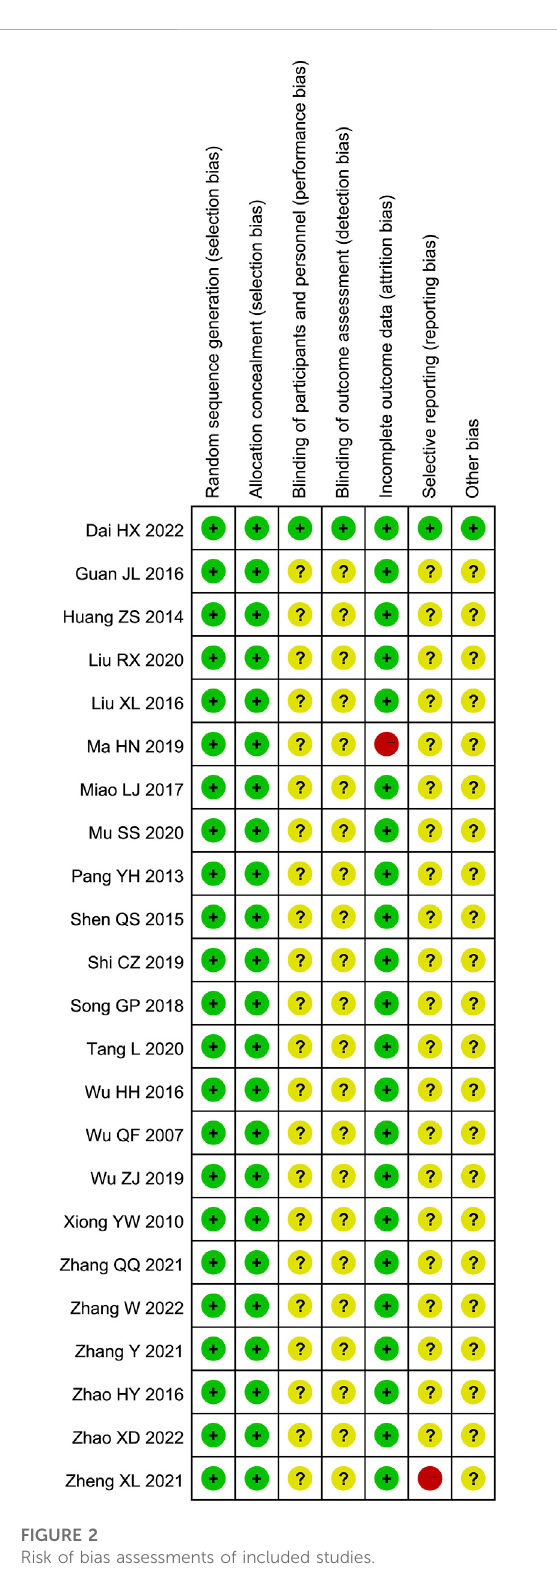
FIGURE 2 Risk of bias assessments of included